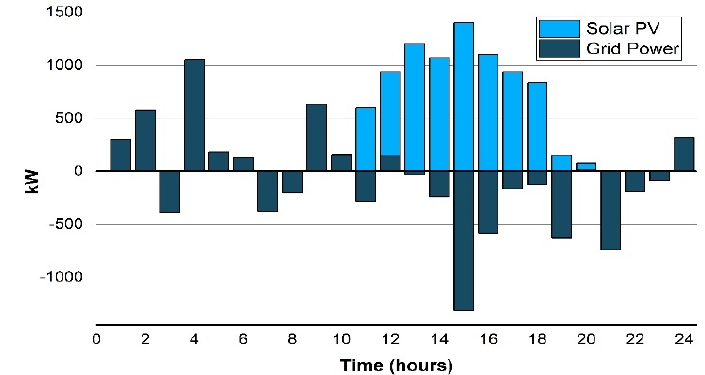
Figure 6. Scenario 1(b): Energy exchange with the power grid.